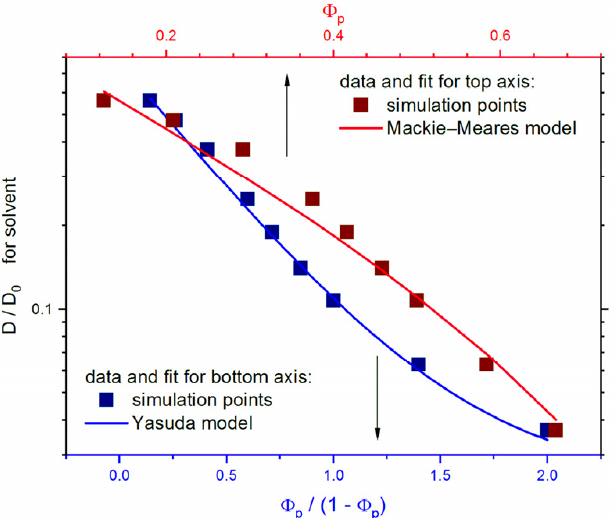
Figure 8. Solvent reduced self-diffusion coefficient D/D 0 as a function of the polymer concentration Φ p (top axis) and Φ p /(1 − Φ p ) (bottom axis). The fits to Mackie–Meares and Yasuda theories are also marked. The case of σ = 0.3. The influence of the grafting density on the reduced self-diffusion is presented in Figure 9. The decrease in solvent mobility is strong, and one can describe it as exponential: D / D 0 ~ exp( − σ ).